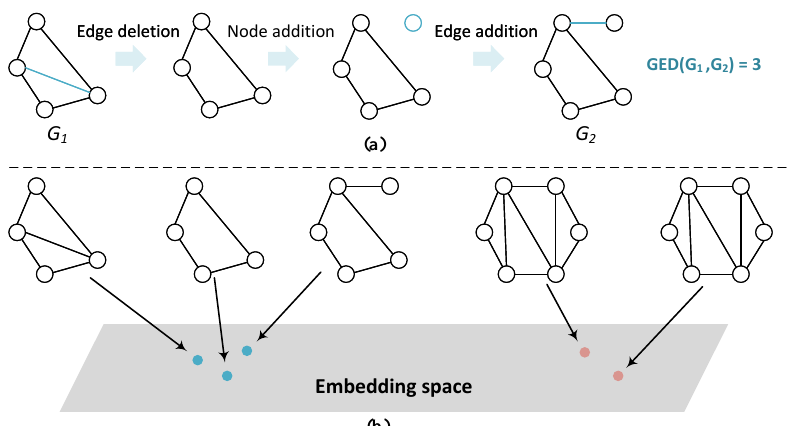
Figure 1. Illustration of graph similarity computation. ( a ) An example of GED computation process. ( b ) An example of neural methods for calculating graph similarity, where similar graphs are projected into the adjacent area in the embedding